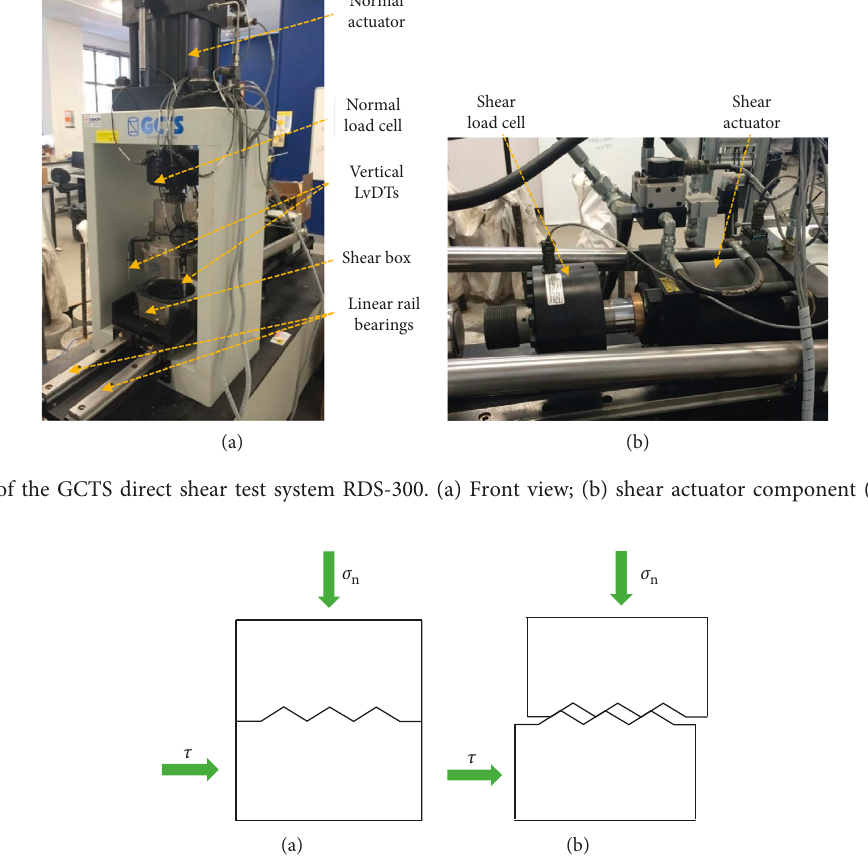
Figure 7: Configuration of closed and opened rock fractures under direct shear. (a) Closed rock fracture; (b) opened rock fracture (after Li et al. [5]). τ and σ n are normal stress and shear stress, respectively.